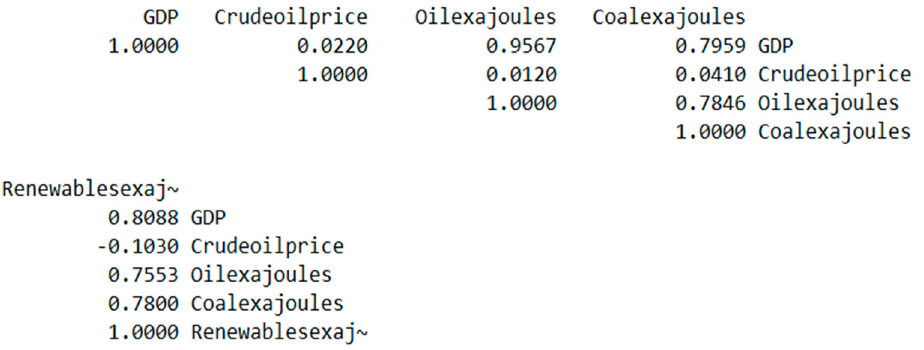
Figure 21. Correlation matrix for the variables for 2006–2020 period. As can be seen, while there were some cases of correlations over 0.75, there were no dramatically high values for correlations between exogenous variables. Moreover, as the signs of coefficients for other periods were the same, we can conclude that there was no multicollinearity present